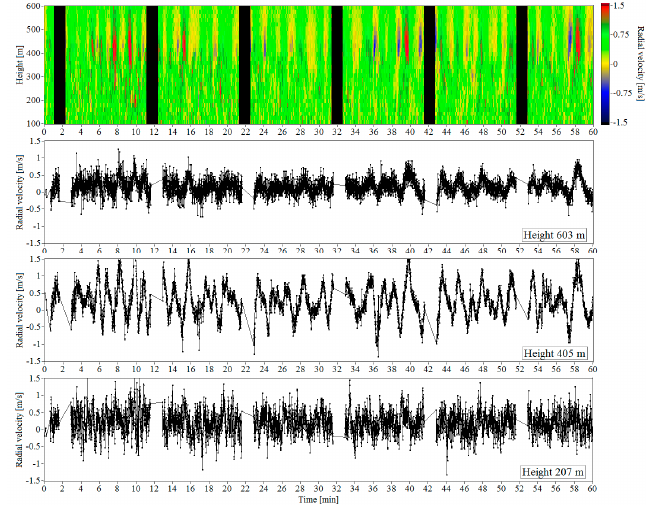
Figure 9. Height–temporal distribution and time series of the radial velocity at heights of 207, 405, and 603 m as obtained from measurements with the vertically pointing lidar for an hour starting from 03:00 LT on 2 July 2020.